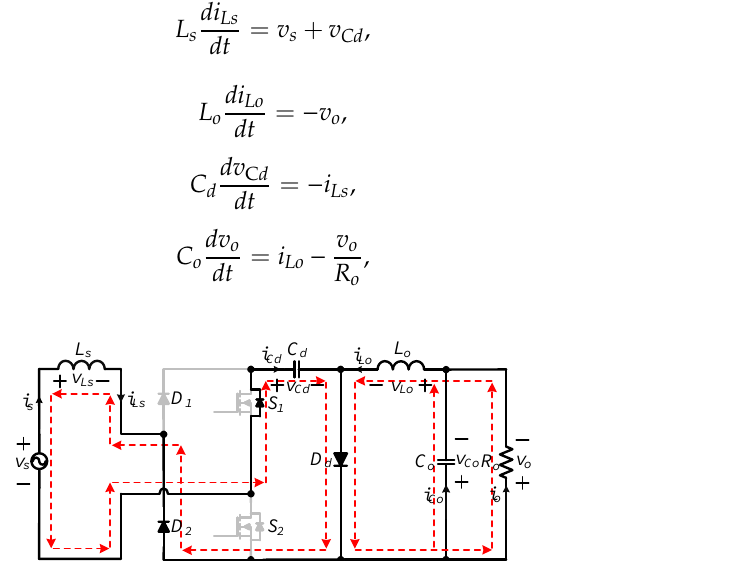
Figure 9. Equivalent circuit of the bridgeless Cuk converter in State 2 during negative half line cycle. (3) State 3 ( t 2 ≤ t <t 3 ): In this state, as shown in Figure 10, switch S 2 is turned off and S 1 is also turned off. Input inductor L s is demagnetized in the inverse direction by the voltage ( V cd + V s ) so as to decrease the inductor current i Ls which flows through diodes D 2 , D d and the body diode of switch S 1 and goes back to the main ac source. The intermediate capacitor C d is charged by the input inductor current i Ls in the inverse direction. Simultaneously, the output inductor L o still releases energy to the load through diode D d . The equivalent circuit equations are given by Equations (21)–(24).